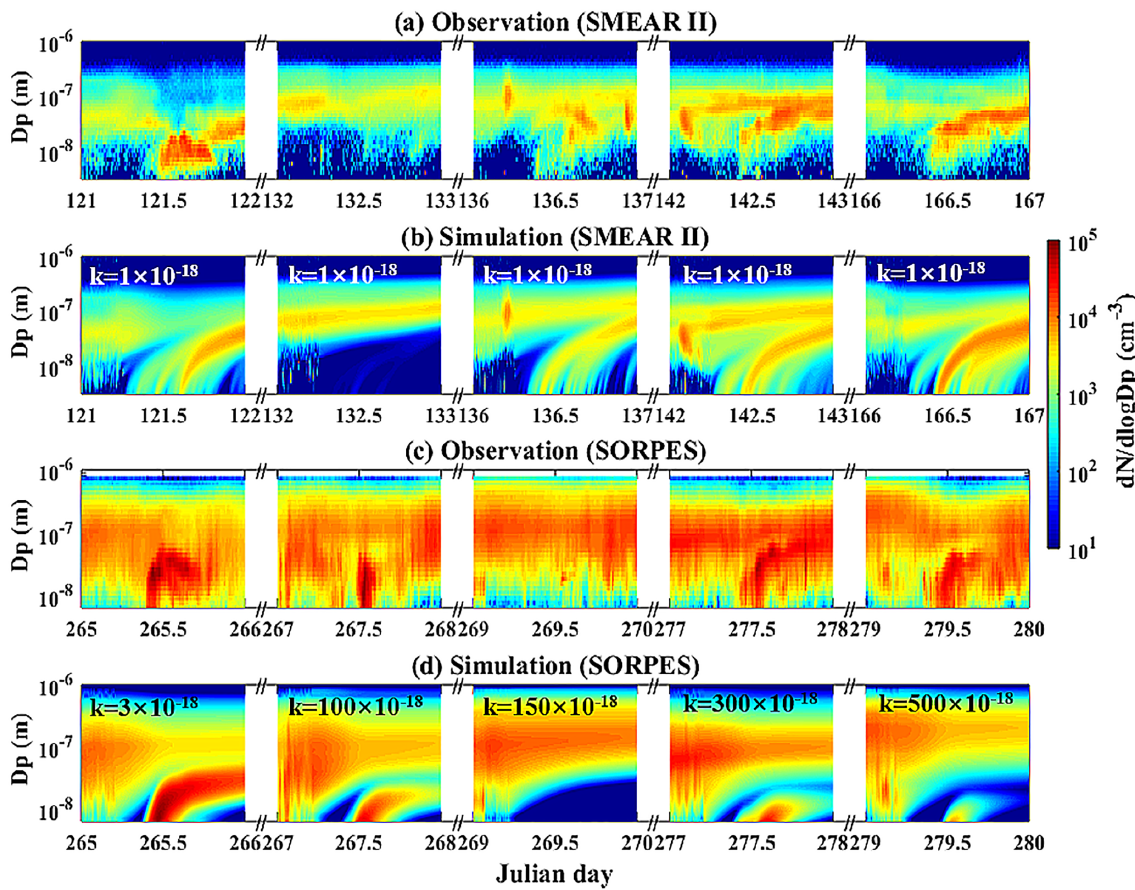
Figure 4. (a, c) Measured and (b, d) simulated particle number size distribution at SMEAR II and SORPES, respectively. Note the kinetic coefficient on each day is shown in Fig. 4b, d.